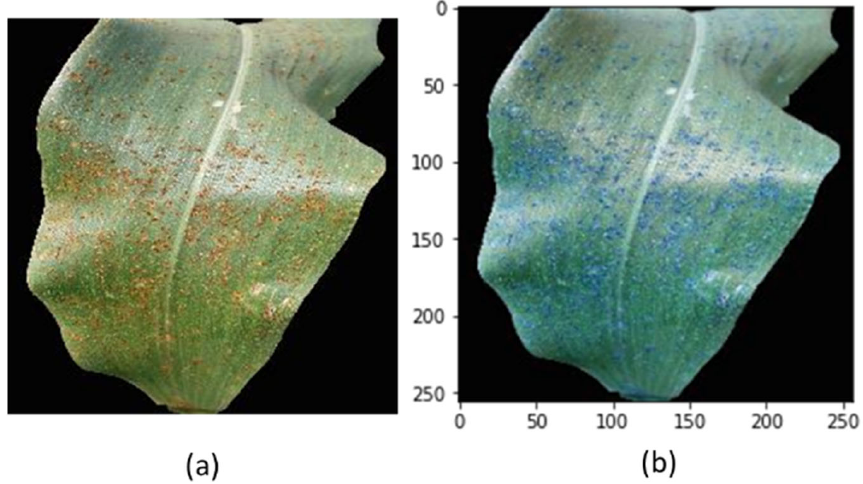
Figure 8. Minute-scale detection in Diseased leaf. ( a ) is corn rust disease and ( b ) is uredinium which is usually reddish of hyphae and spore of a rust fungus.